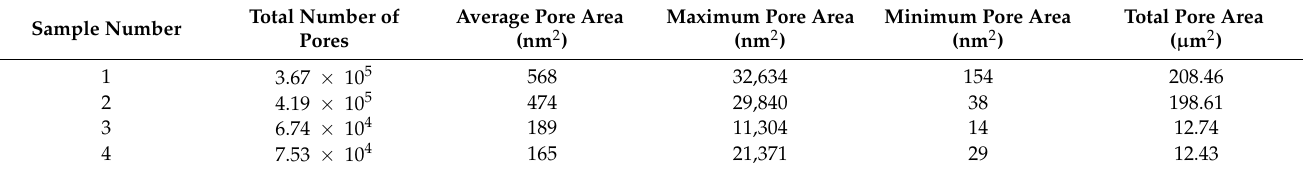
Table 2. Observation and analysis results of nanopore in C-S-H (the analysis area is 0.01 mm 2